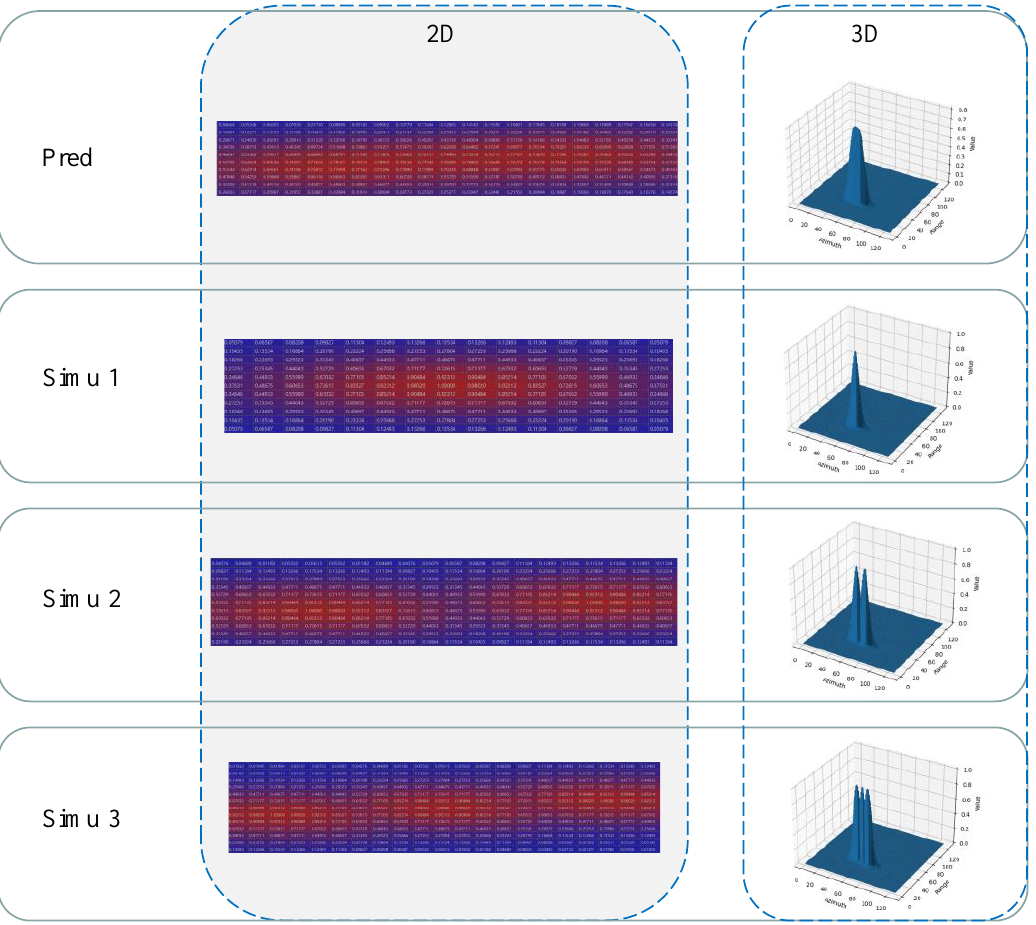
Figure 15. GMM-TN instance implementation diagram. In order to show the spatial distribution more intuitively, we also show the 3D schematic diagram.